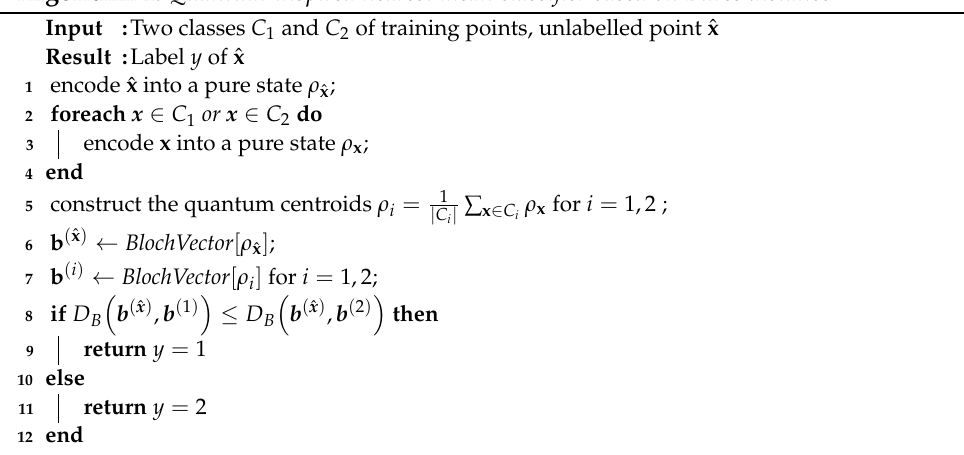
Algorithm 1: Quantum-inspired nearest mean classifier based on Bures distance.